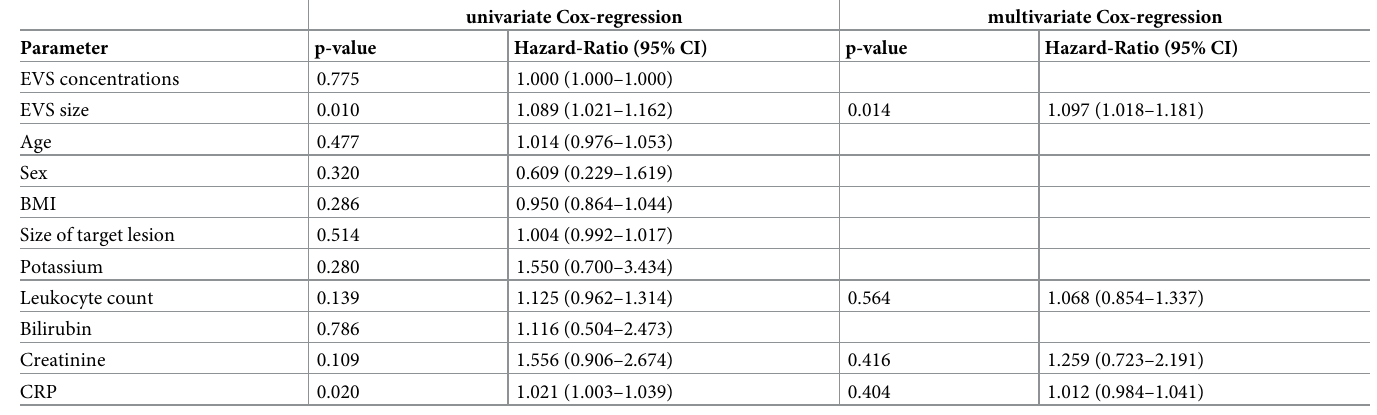
Table 2. Uni- and multivariate Cox-regression analysis for the prediction of overall survival after TACE.